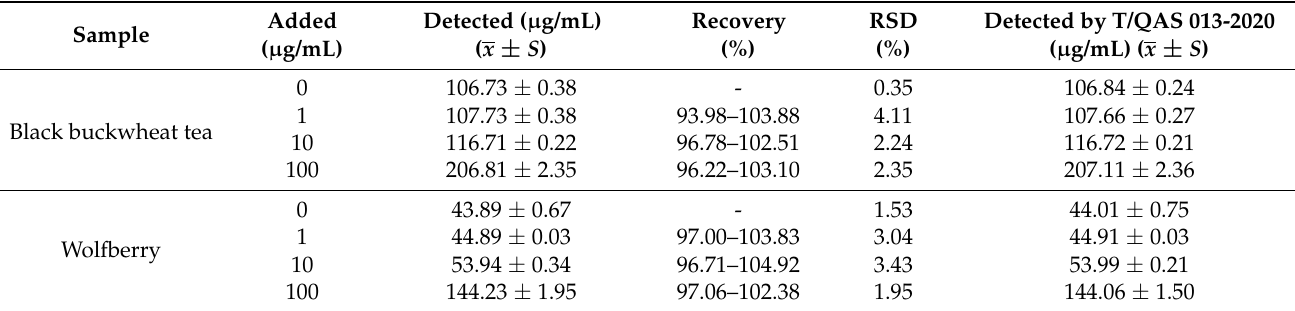
Table 3. Recovery, precision, and accuracy of determination of rutin in samples ( n =